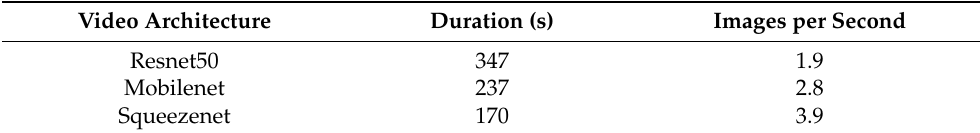
Table 3. Video processing